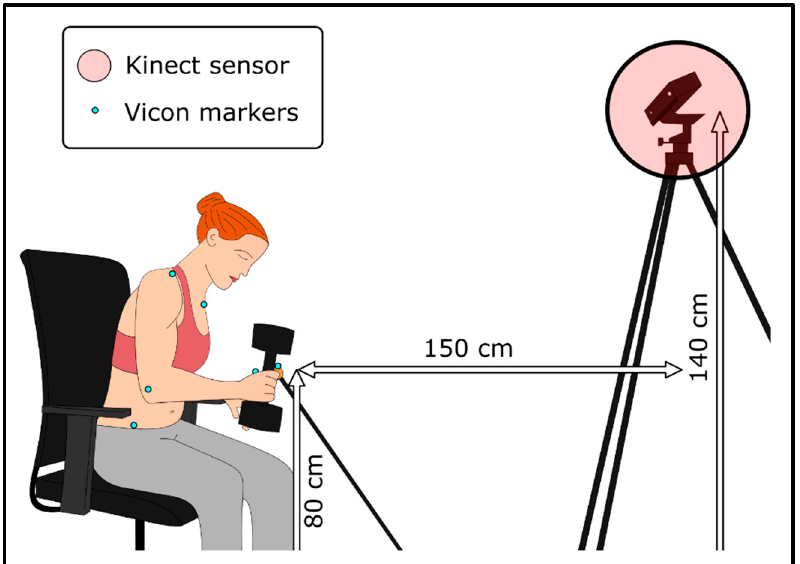
Figure 1. Experimental setup. 3D upper limb kinematics were simultaneously recorded by the Kinect and the Vicon motion capture systems. Vicon markers were placed on the target, hands, elbows, shoulders, manubrium and hips of the participant as close as possible to the joint centres located by the Kinect. The Kinect was located in front of the participant, at a distance of 1.50 m and a height of 1.40 m. The target (orange table tennis ball) was located at a height of 0.80 m, just within the anatomical reaching distance for the hand.